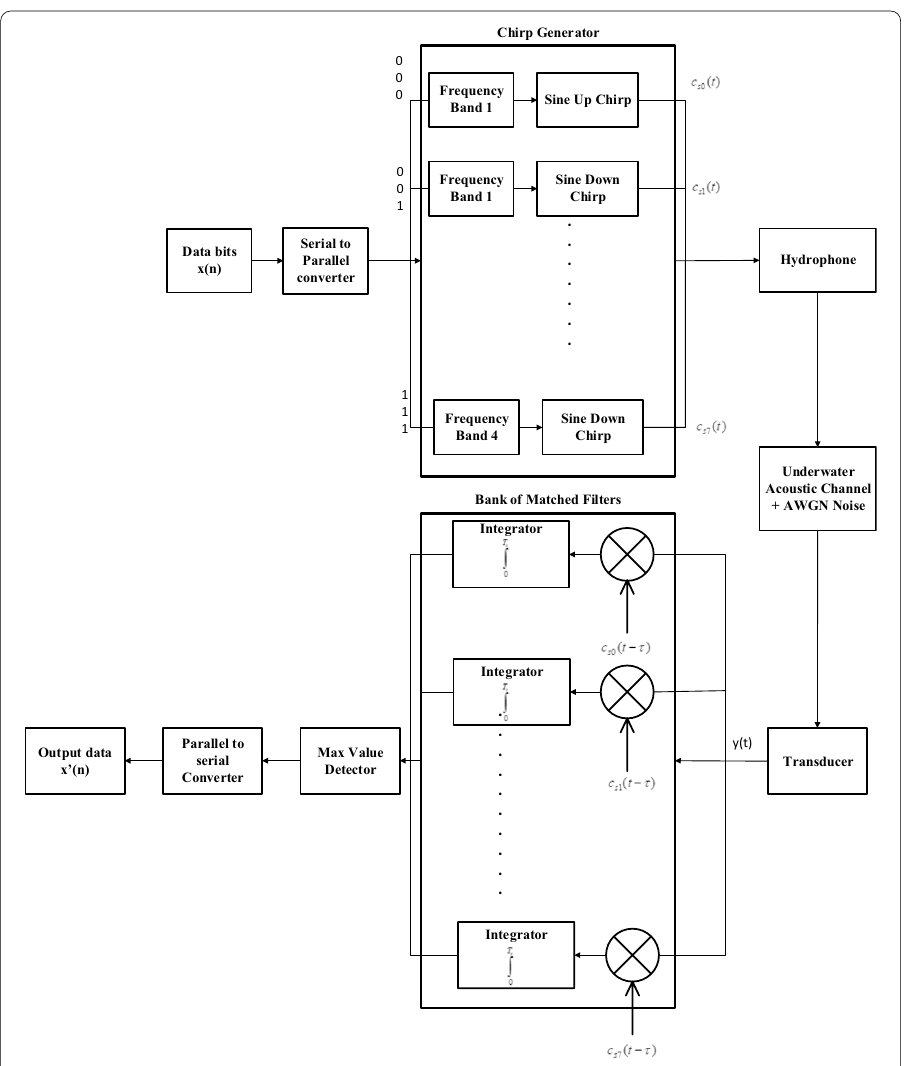
Fig. 7 Block diagram of 8-ary sine chirp spread spectrum communication